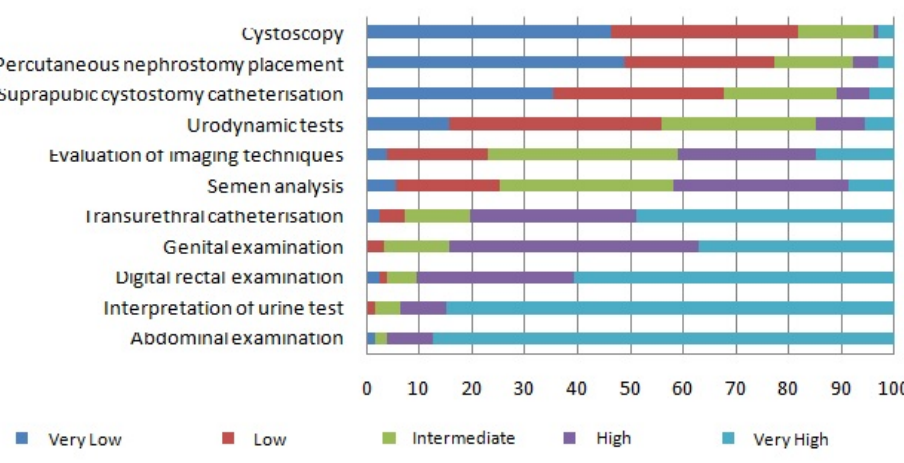
Figure 1. Evaluation of urological knowledge: objective questions.